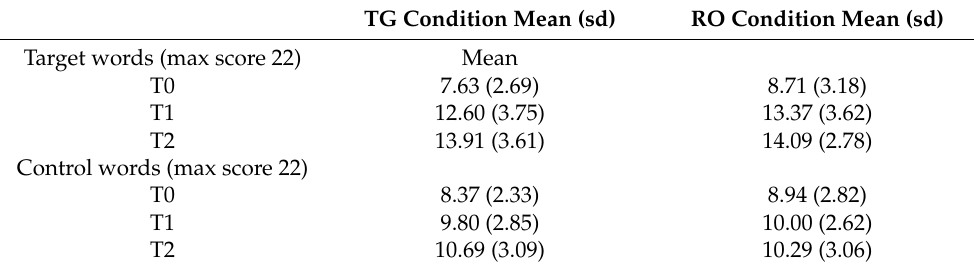
Table 2. Means and standard deviations (sd) of correct target words and control words on the receptive vocabulary picture selection task in TG (tablet game) and RO (real objects) conditions at the three time